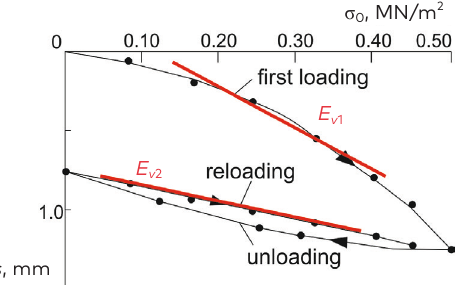
Figure 1. Load vs. settlement graphs for loading, unloading and